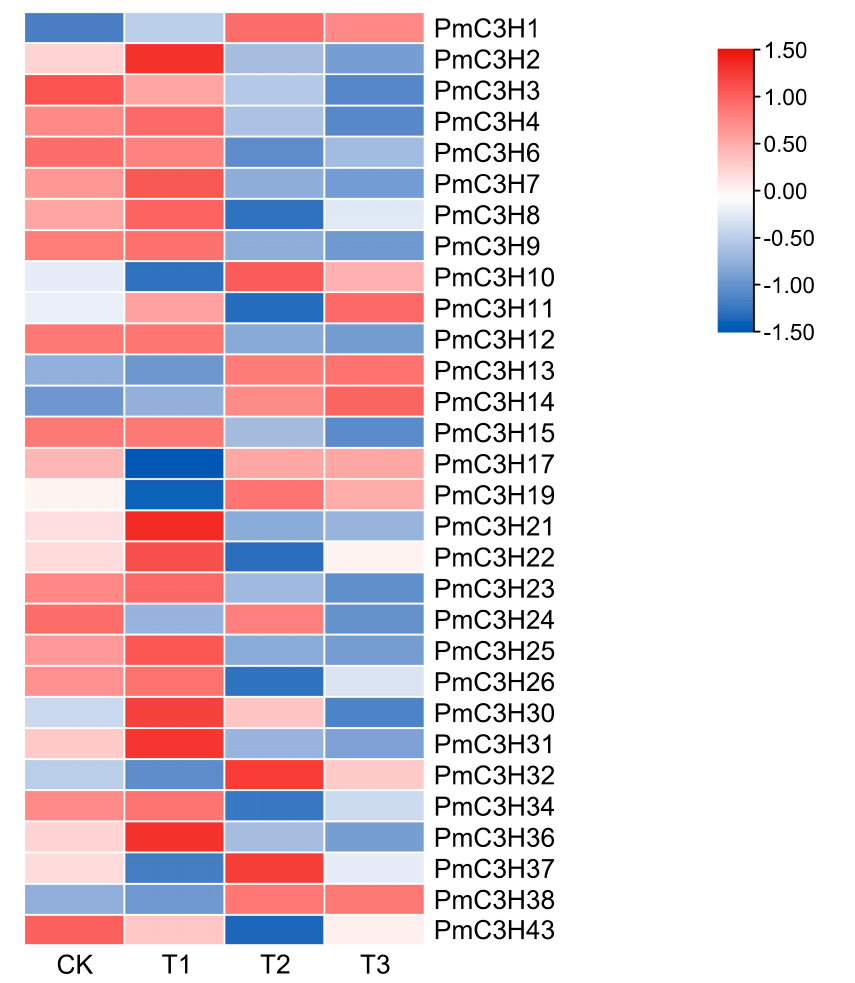
Figure 4. Transcriptional profiles of CCCH family members in P. massoniana under different drought levels: CK (80 ± 5)%, T1 (65 ± 5)%, T2 (50 ± 5)% and T3 (35 ± 5)%. Heat maps were generated using log2 (FPKM + 0.01) values, then performed row scale. The color scale represents relative expression levels based on the values of log2 fold change scale. Dark blue indicates a low expression level, light color indicates a medium level and red indicates a high